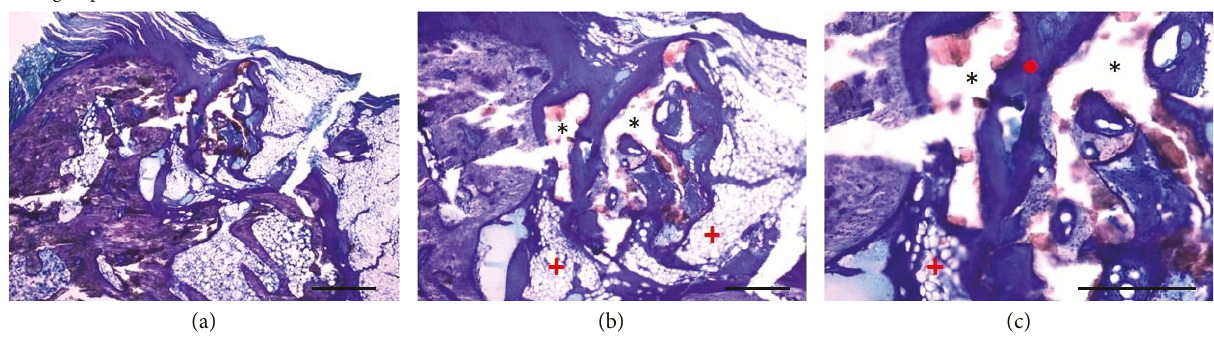
Figure 4: Photomicrographs of histological sections stained with toluidine blue taken from the TCP group (a – c). (a) The defect area was still evident 12 weeks after surgery. Connective tissue and adipose bone marrow were generated at the injured area (scale bar: 1000 μ m). (b) The remaining TCP material was not fully osteointegrated ( ∗ ) (scale bar: 500 μ m). (c) Scarce trabecular bone formation in association with TCP granules. Nonosteointegrated TCP granules ( ∗ ) were surrounded by connective tissue (red circle) or adipose bone marrow (red plus sign) (scale bar: 500 μ m).